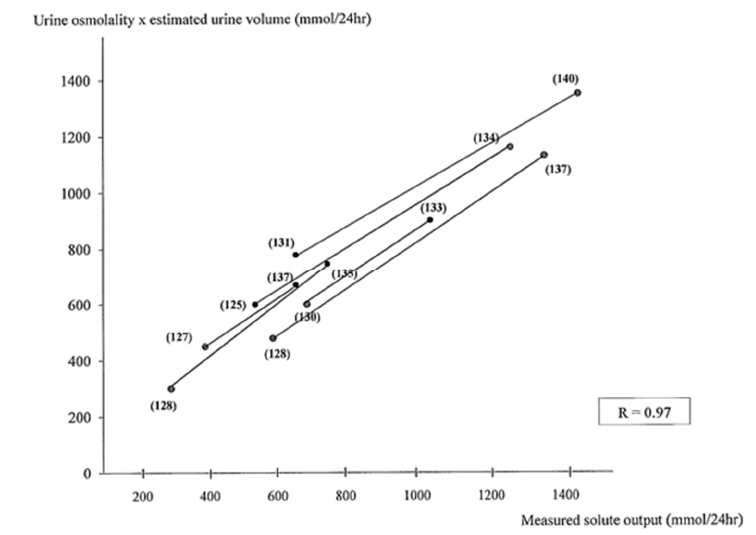
Figure 5. Evolution of SNa in six patients with chronic hyponatremia related to SIADH treated by urea (2 patients with 15 g / day and 4 patients with 30 g / day) (see Table 3). Estimated urine volume was obtained by the formula: eCcr × 1440 × S.Creat / U.Creat.100 in % (y = –38.3 + 1.035 x; r = 0.97; p < 0.001).